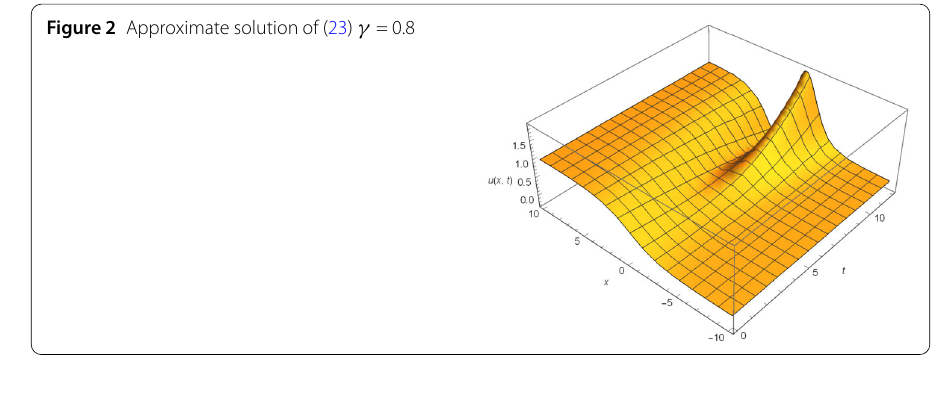
Figure 2 Approximate solution of (23) γ = 0.8